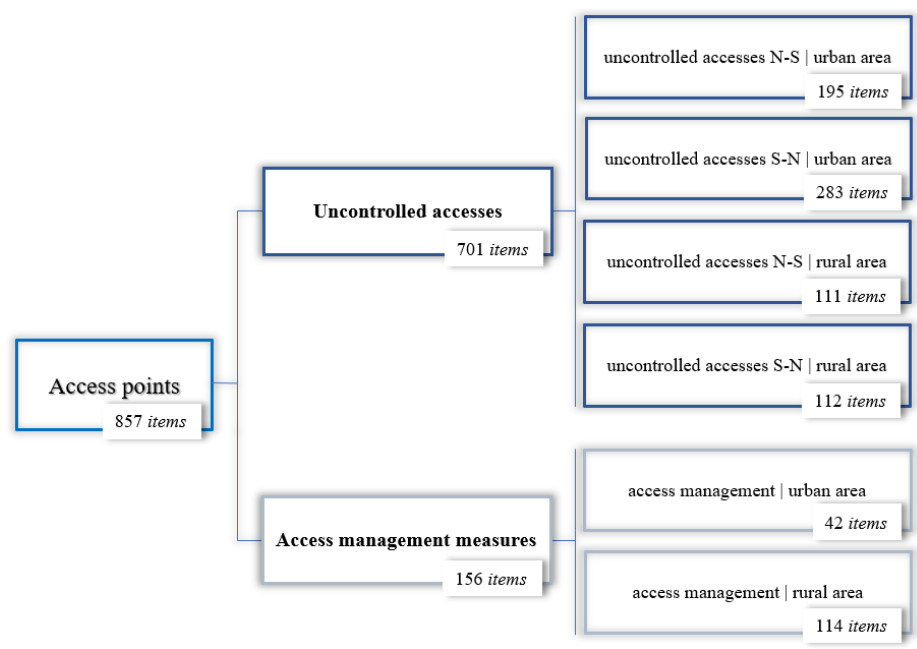
Figure 1. Summary of the elements characterised in the